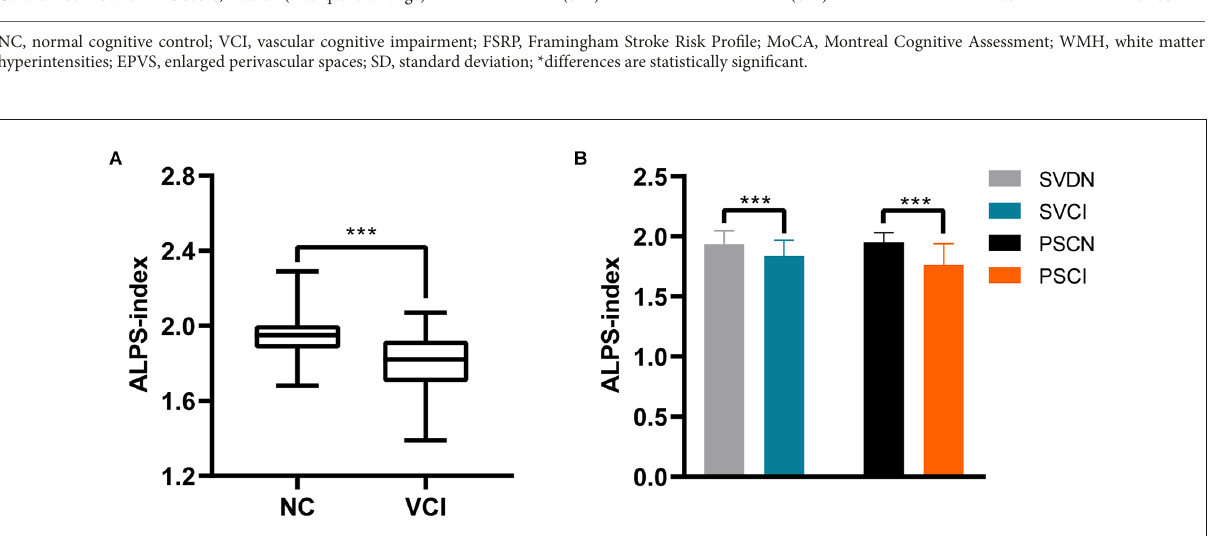
FIGURE2 Differences of ALPS-index between NC and VCI groups (A) . Differences of ALPS-index between SVDN and SVCI, PSCN and PSCI (B) . NC, normal cognitive control; VCI, vascular cognitive impairment; SVDN, cerebral small vessel disease with normal cognition; SVCI, cerebral small vessel disease cognitive impairment; PSCN, post-stroke cognitively normal; PSCI, post-stroke cognitive impairment; ALPS, analysis along the perivascular space. *** P <